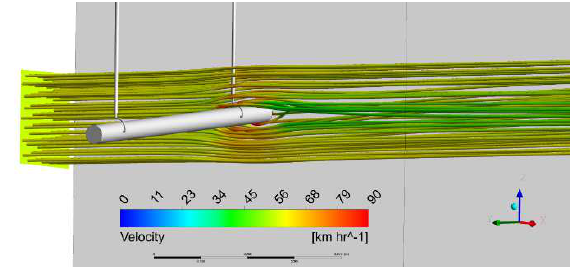
Fig. 4. Stream lines around a part of the light element.